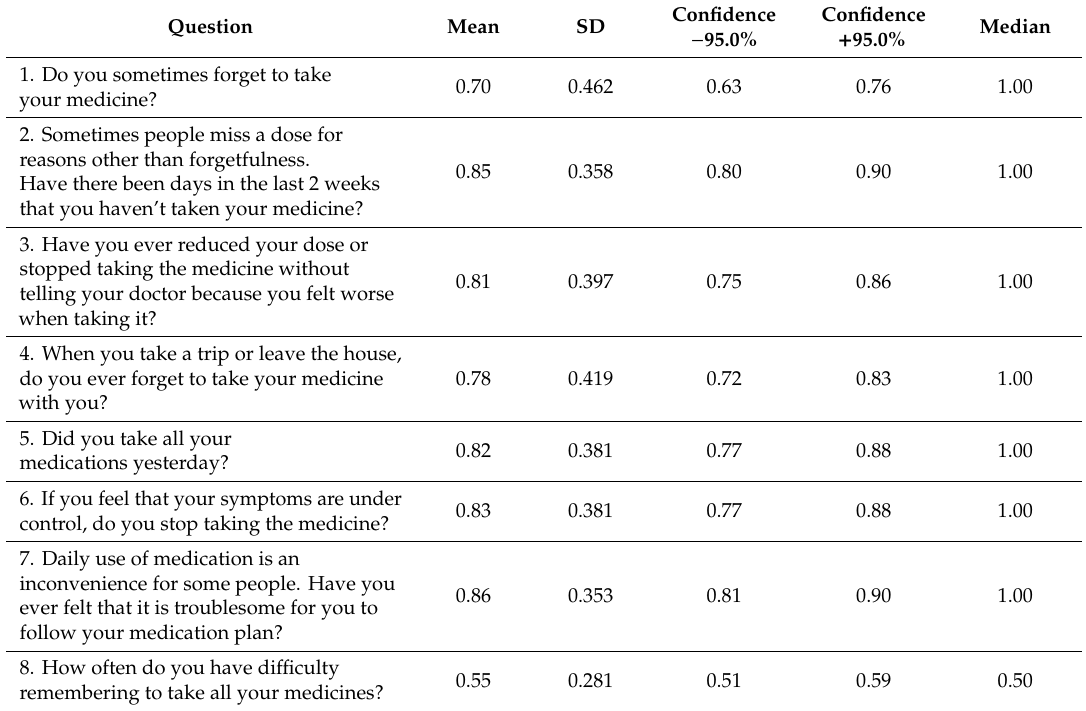
Table 5. Answers to individual questions of the MMAS − 8 questionnaire